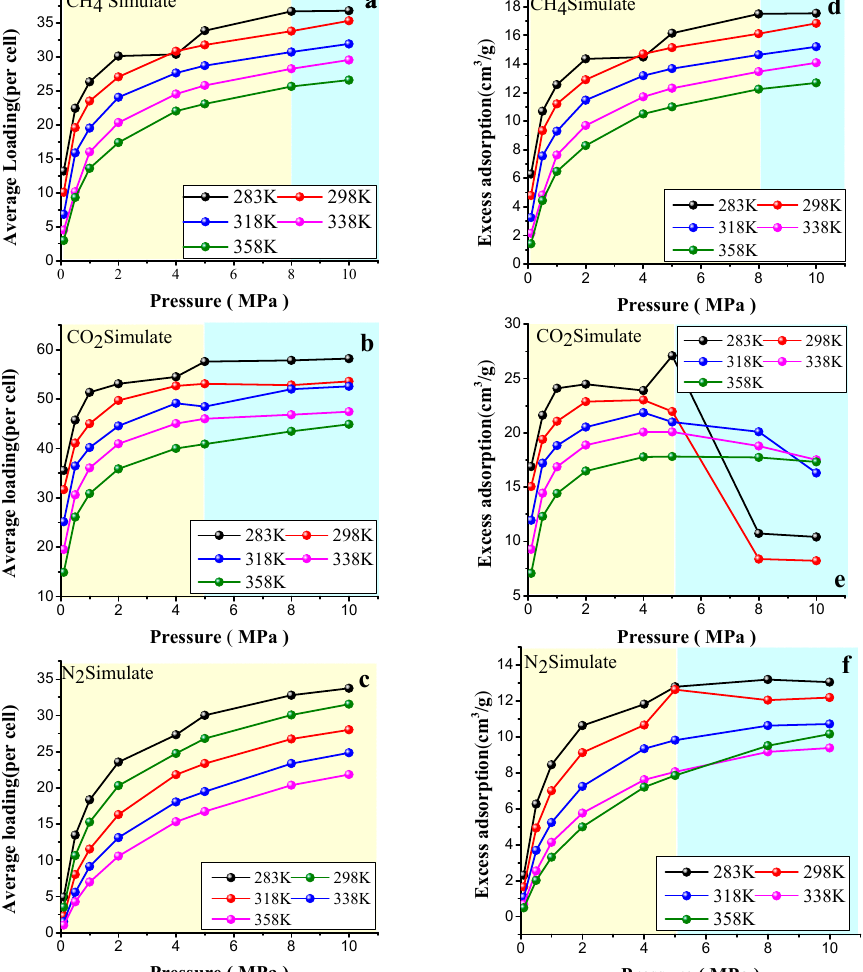
Figure 8. Adsorption isotherm of CH 4 / CO 2 and N 2 at 283–358 K obtained through the grand canonical Monte Carlo (GCMC) method. ( a ) the average loading (per cell) of CH 4 at 283–358 K. ( b ) the average loading (per cell) of CO 2 at 283–358 K. ( c ) the average loading (per cell) of N 2 at 283–358 K. ( d ) the excess adsorption of CH 4 at 283–358 K. ( e ) the excess adsorption of CO 2 at 283–358 K. ( f ) the excess adsorption of N 2 at 283–358 K.